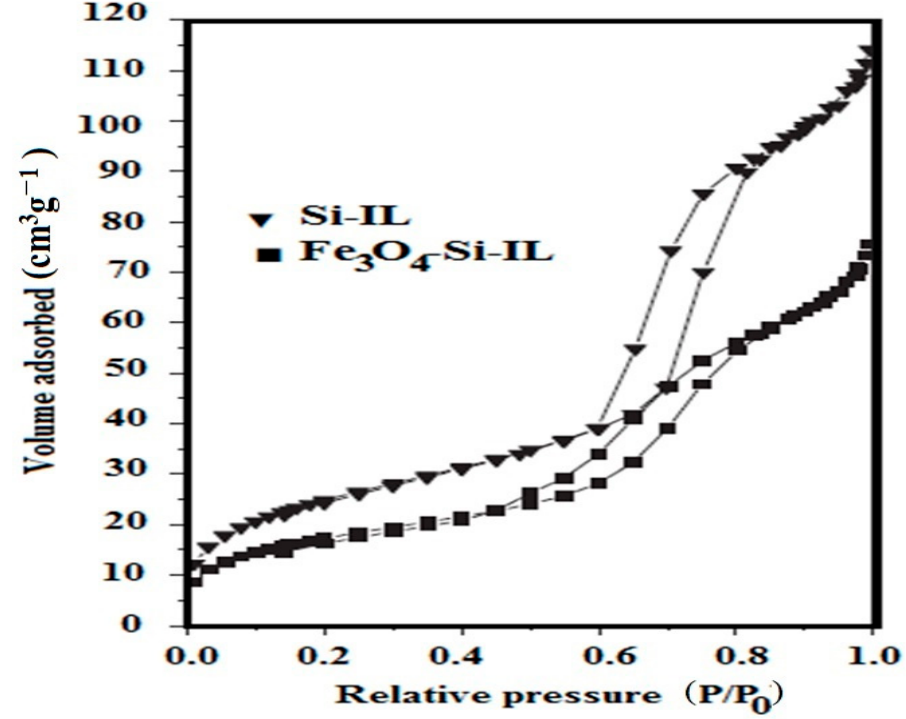
Figure 9. Brunauer-Emmett-Teller (BET) data of the prepared Si-IL and Fe 3 O 4 -Si-IL.